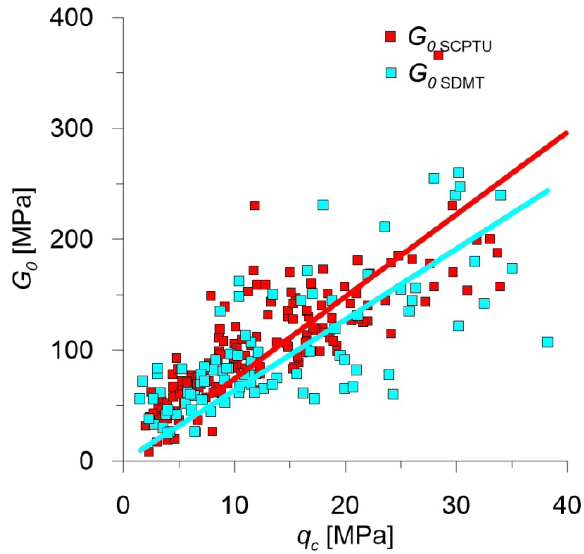
from SCPTU and 0 (data set at all test c